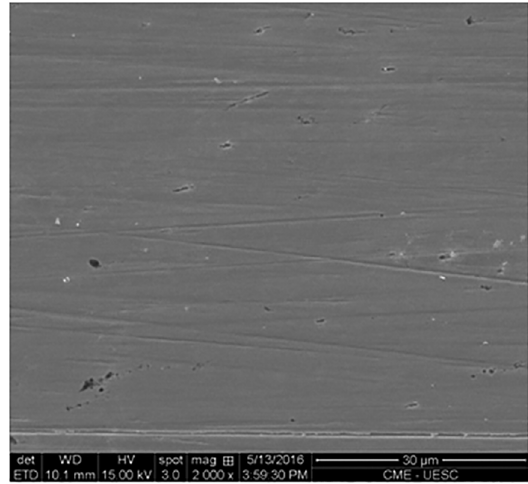
Figure 7. SEM micrograph of ground AISI 1020 carbon steel.